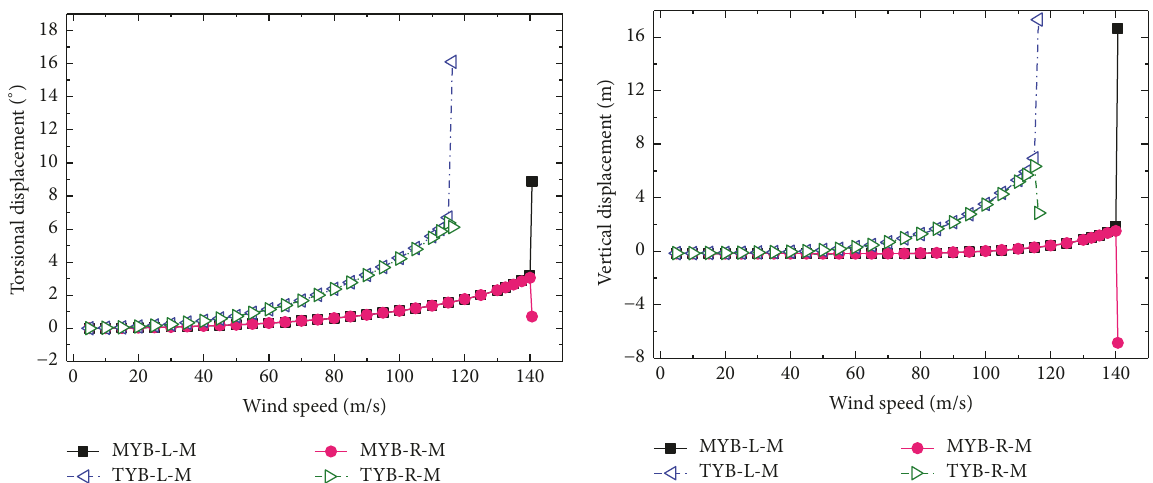
Figure 8: The torsional and vertical displacements for MYB and TYB with initial attack angles of +3 ∘ . L: left; R: right; M: midspan point.